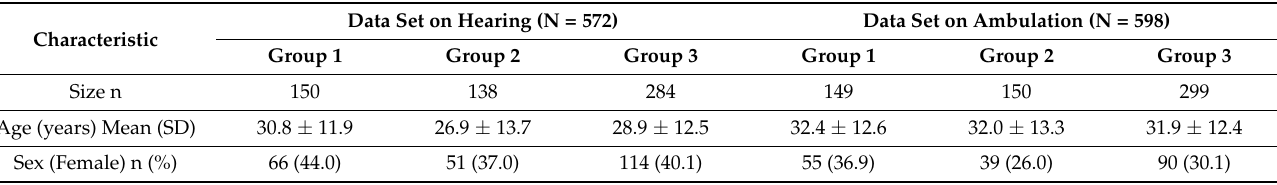
Table 2. Characteristics of the